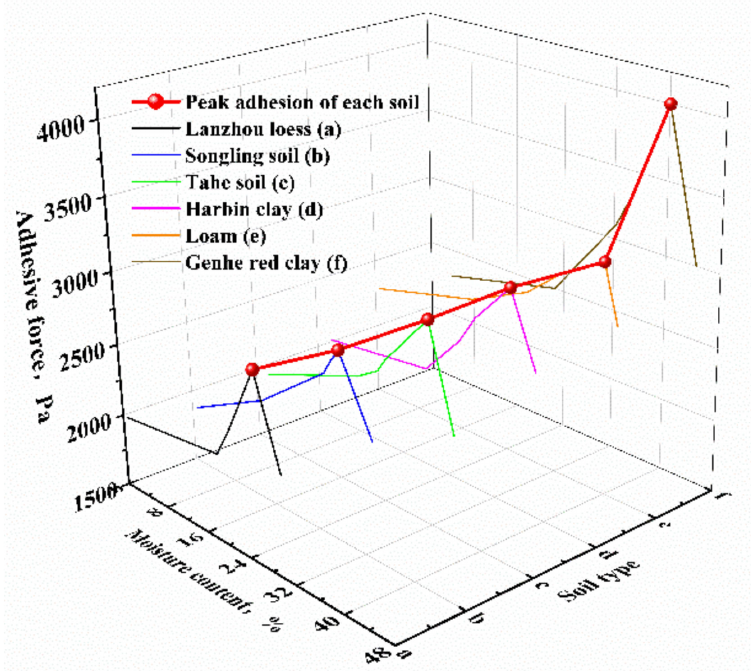
Figure 6. Summary of adhesive force curves for each tested